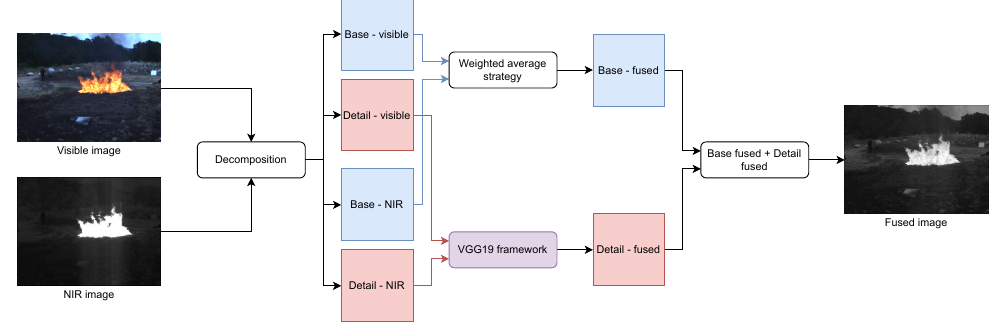
Figure 4. Framework of the VGG19 proposed by Li et al.